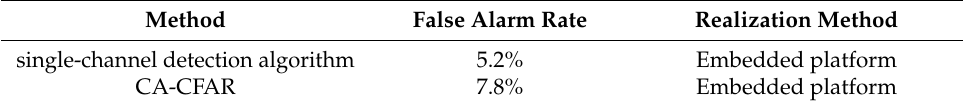
Table 5. Comparison of detection performance of single-channel detection algorithm with CA-CFAR.